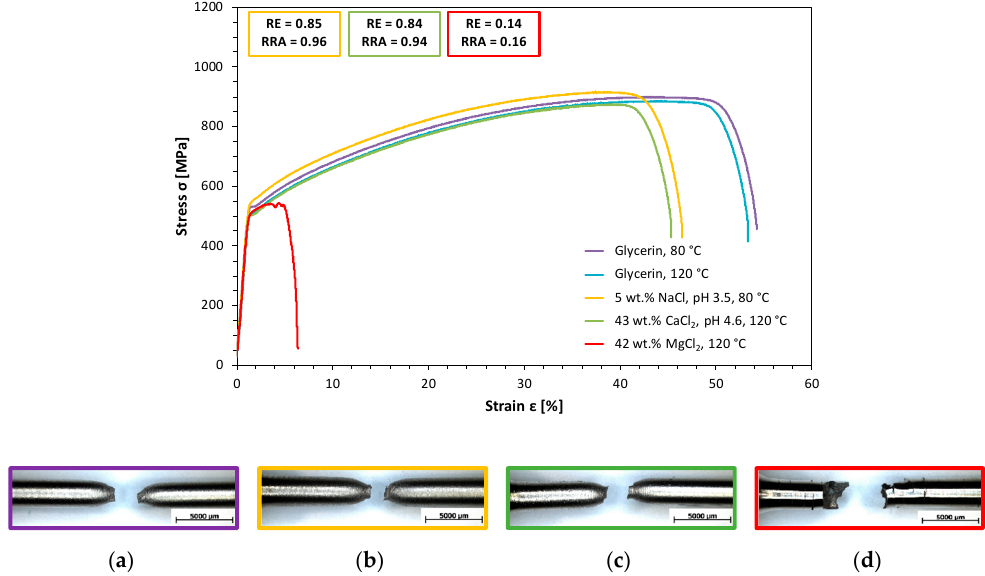
Figure 7. Cl - SCC results for different solutions and optical microscopy of selected samples after SSRT testing: ( a ) Glycerine, 120 °C, ( b ) 5 wt.% NaCl pH 3.5, 80 °C, ( c ) 43 wt.% CaCl 2 , 120 °C, ( d ) 42 wt.% MgCl 2 , 120 °C.